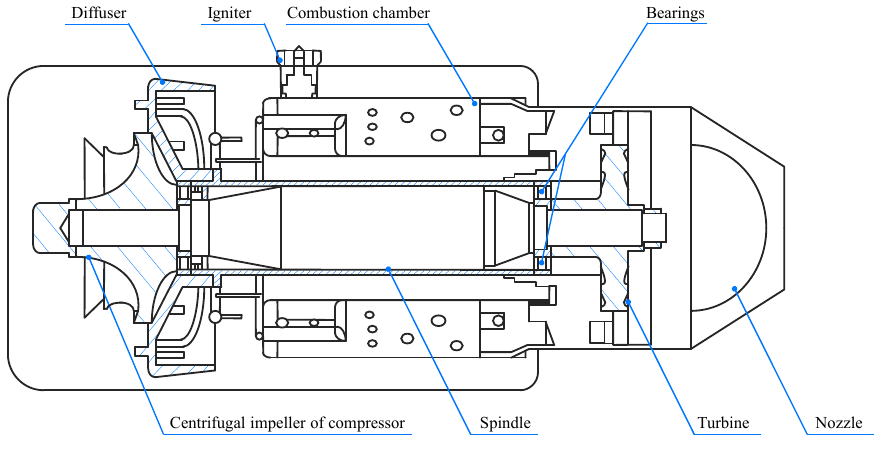
Figure 1. A schematic diagram of a turbojet engine.